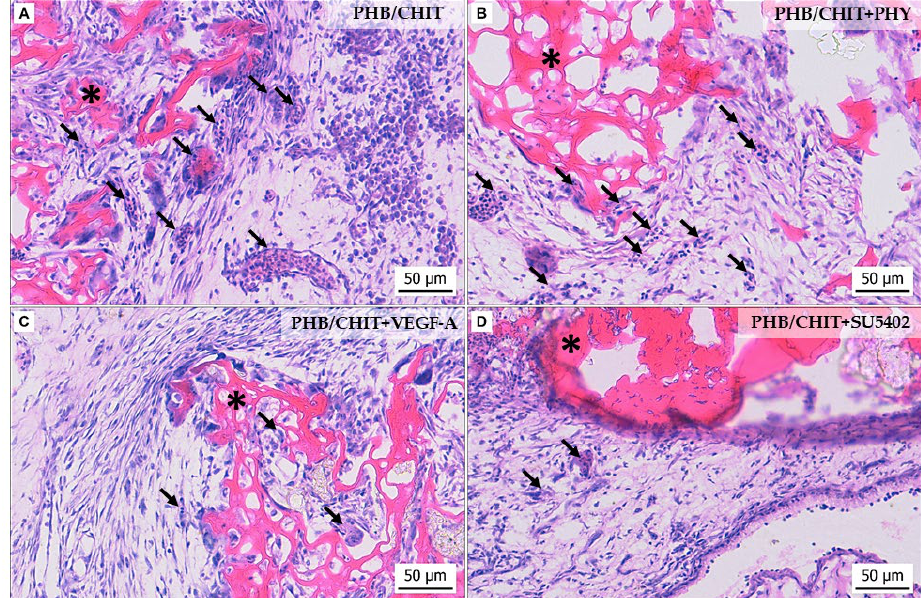
Figure 3. Histological evaluation of the angiogenic response of the CAM tissue 72 h after the implantation of the PHB/CHIT scaffold ( A ) depending on the treatment with PHY ( B ), VEGF-A ( C ) and tyrosine kinase inhibitor (SU5402) ( D ); PHB/CHIT scaffold (asterisk) implanted on the top of the CAM; the vessels of the CAM growth into the material (arrow), staining: H-E; scale bar: 50 µ m.